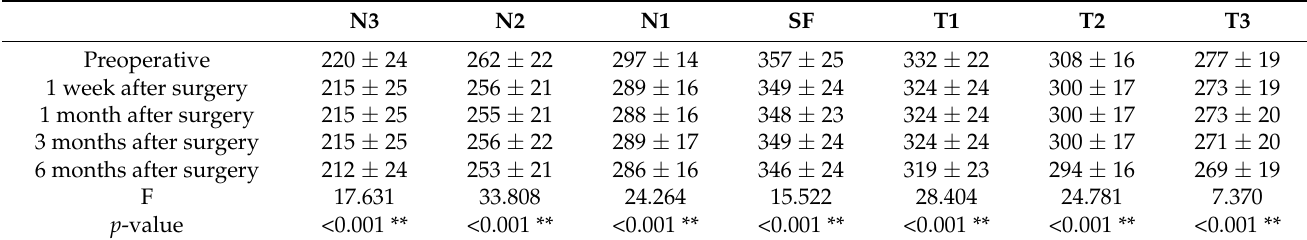
Table 8. Comparisons of CT pre- and postoperatively in the PEI